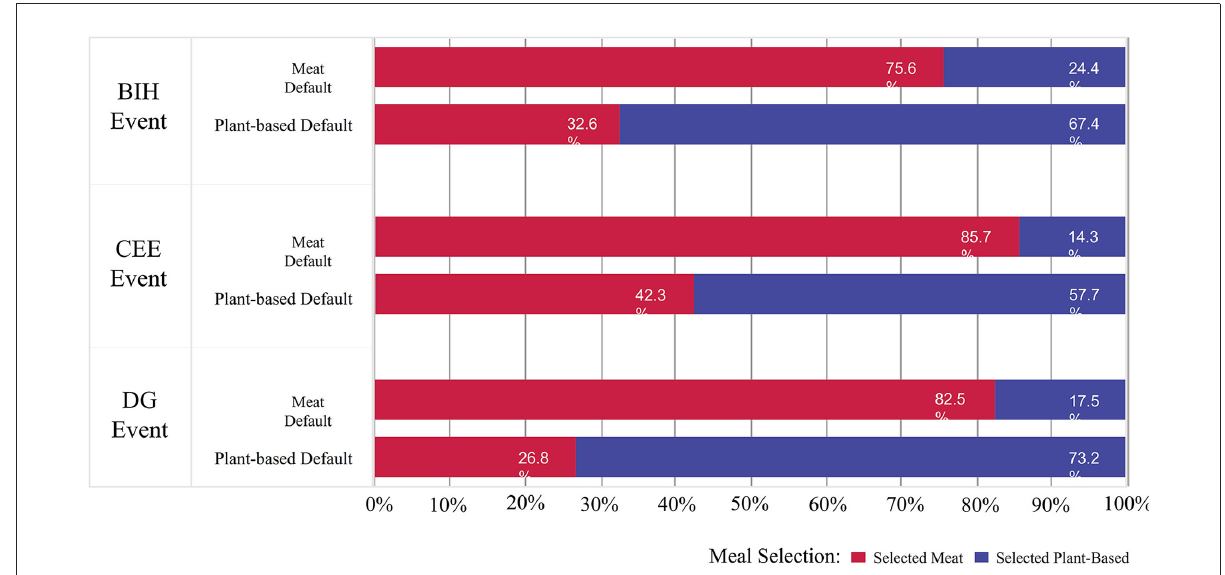
FIGURE1 Percentages of plant-based and meat meal selection among control (meat default) and intervention groups (plant-based) for events.